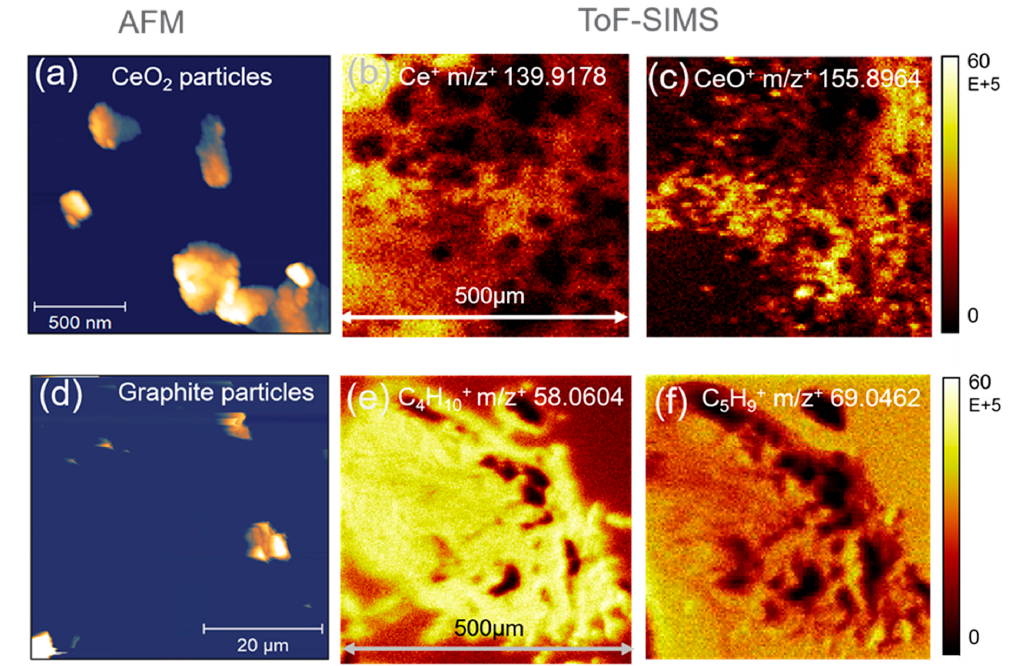
Figure 3. AFM and ToF-SIMS 2D mapping of the working electrodes containing nanoparticles: ( a ) AFM image of CeO 2 ; ToF-SIMS 2D mapping of Ce + ( b ) and CeO + ( c ) on the as-made working electrode (WE) using CeO 2 sequence stamping; similarly ( d ) AFM image of graphite; ToF-SIMS 2D mapping of C 4 H 10 + ( e ) and C 5 H 9 + ( f ) on the as-made WE using graphite mixing and